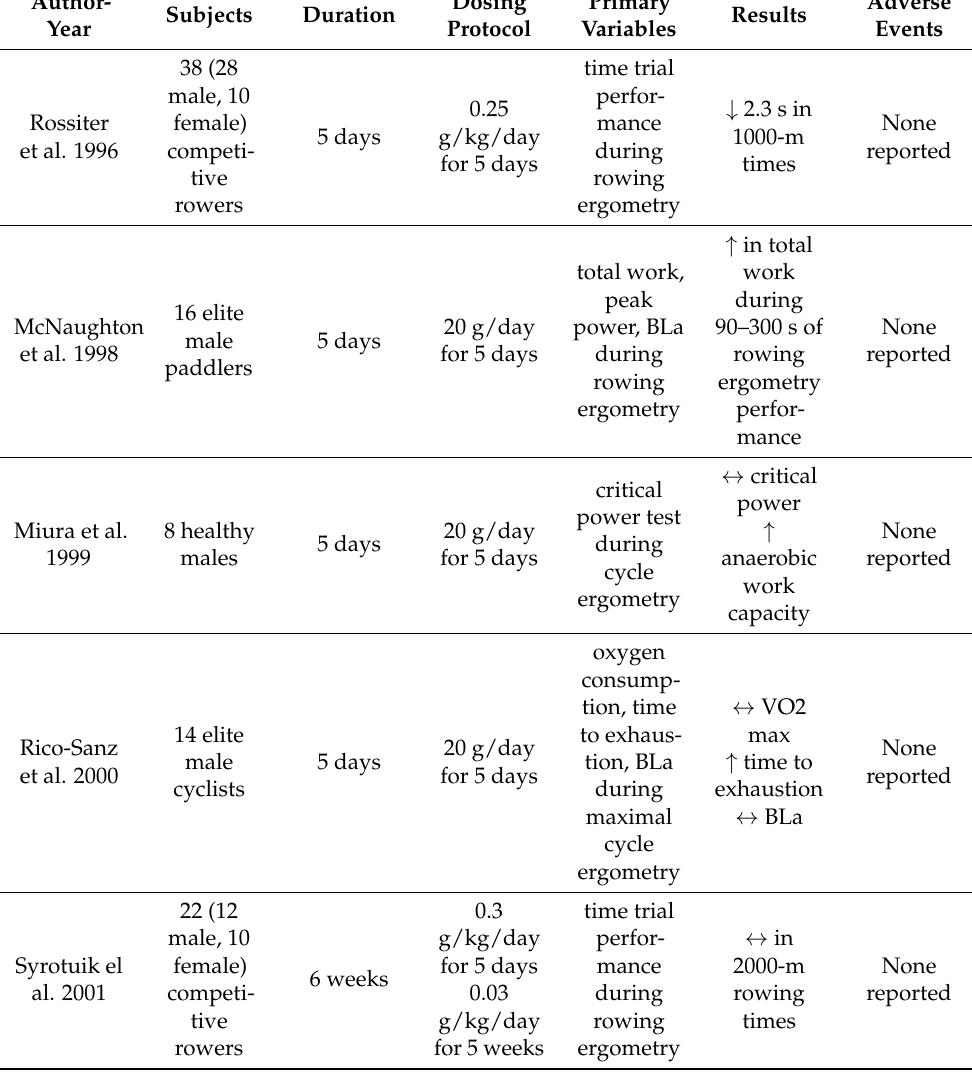
Table 6. Summary of selected studies examining the effects of creatine supplementation on endurance